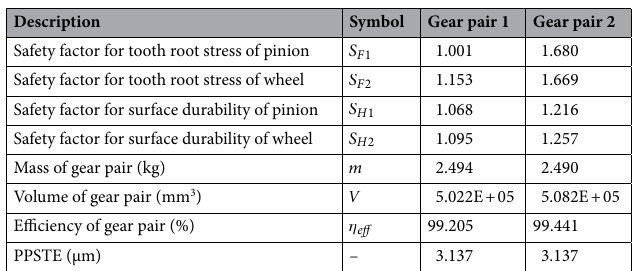
Table 3. Performance metrics of gear pairs without considering manufacturing